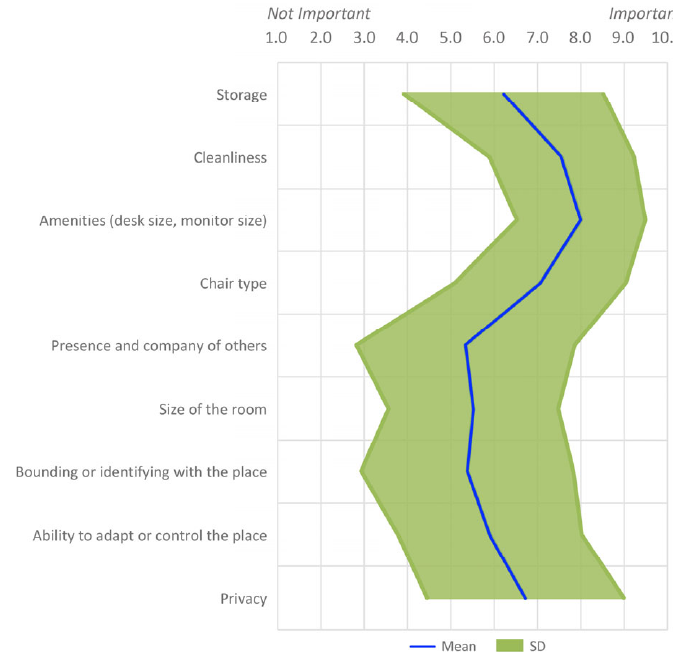
Figure 2. Psychosocial preferences of study places.